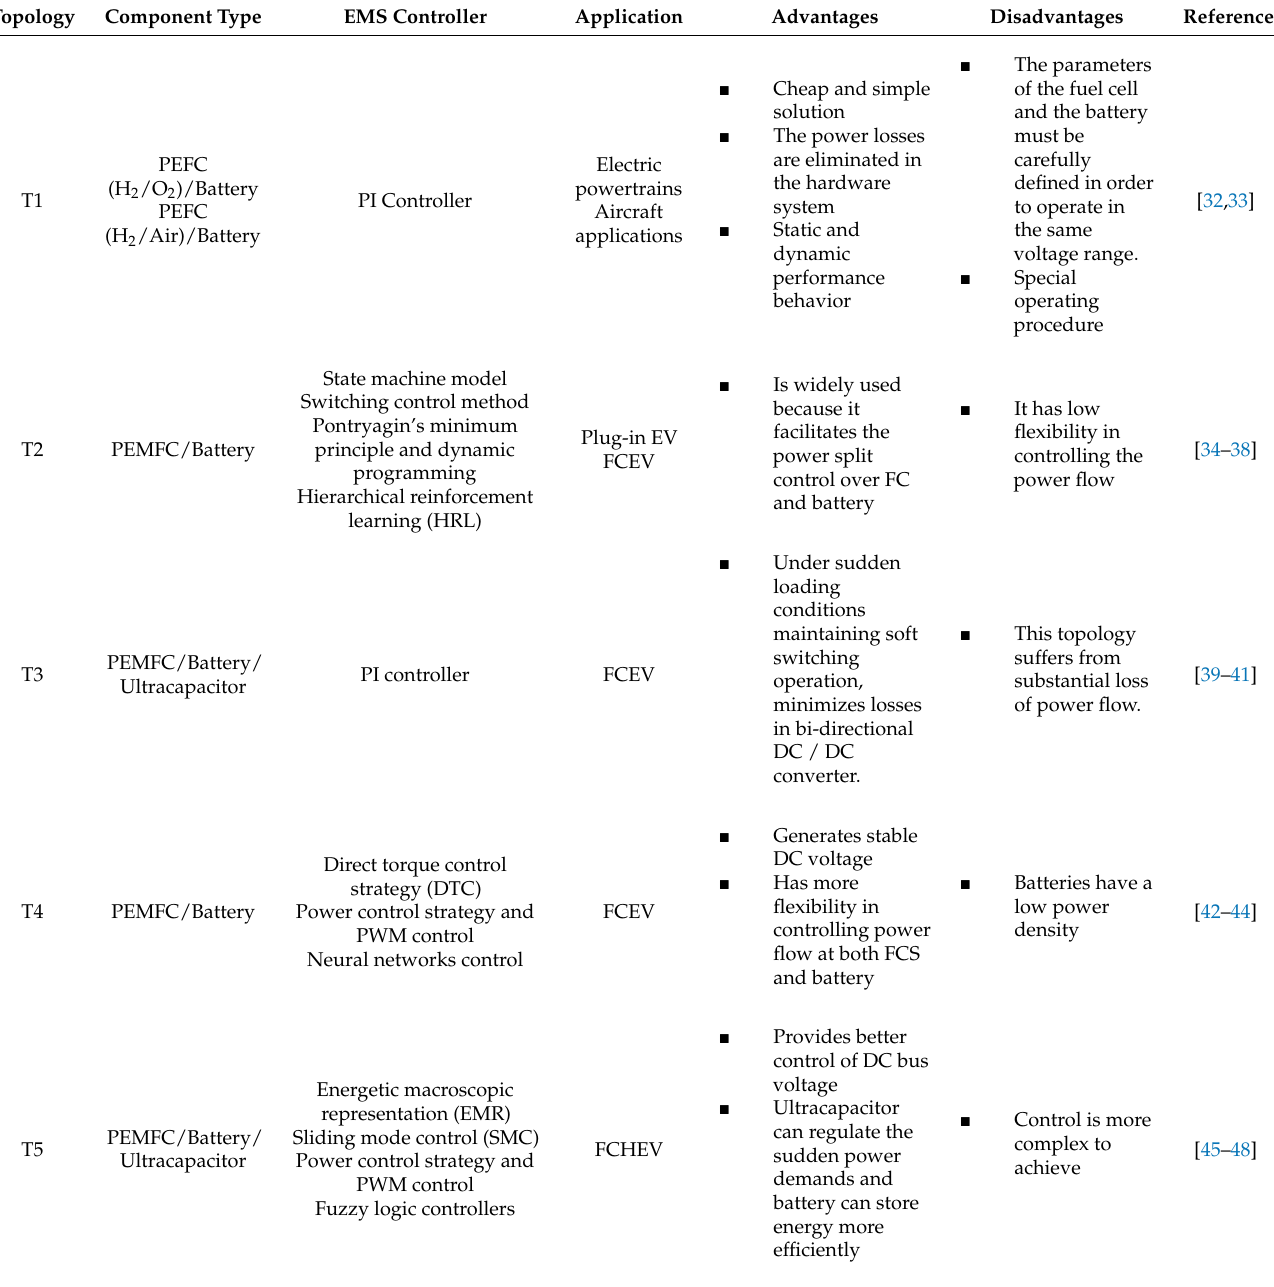
Table 1. Summary description of FCEV’s and Fuel Cell Hybrid Electric Vehicle (FCHEV’s) topologies.